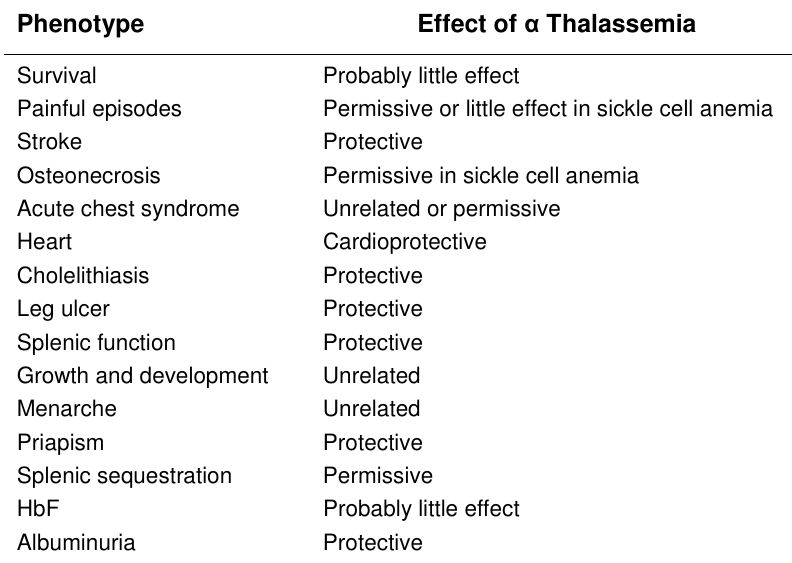
Effect of α Thalassemia on Some Clinical Complications of Sickle Cell